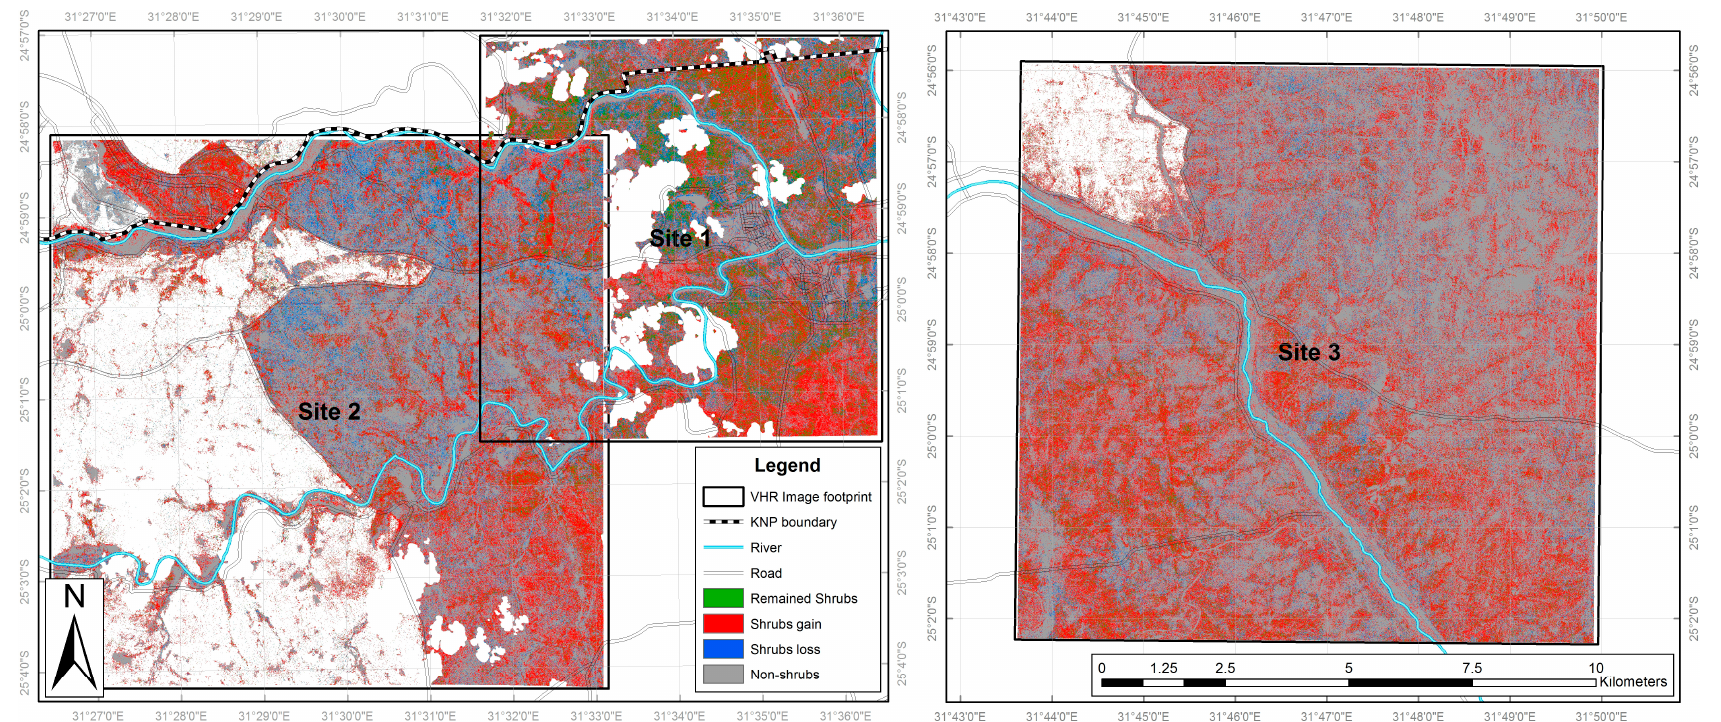
Figure 6. Shrub change map illustrating areas of shrub increase, decrease, continued presence and absence.